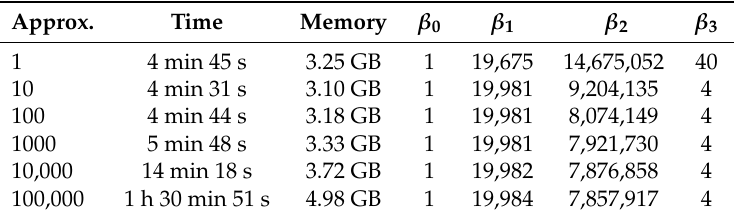
Table 5. Performance of F LAGSER on an Erd˝os-Rényi graph with respect to different values of the Approximate parameter. The Betti numbers range from dimension 0 to dimension 3. Approx. Time Memory β 0 β 1